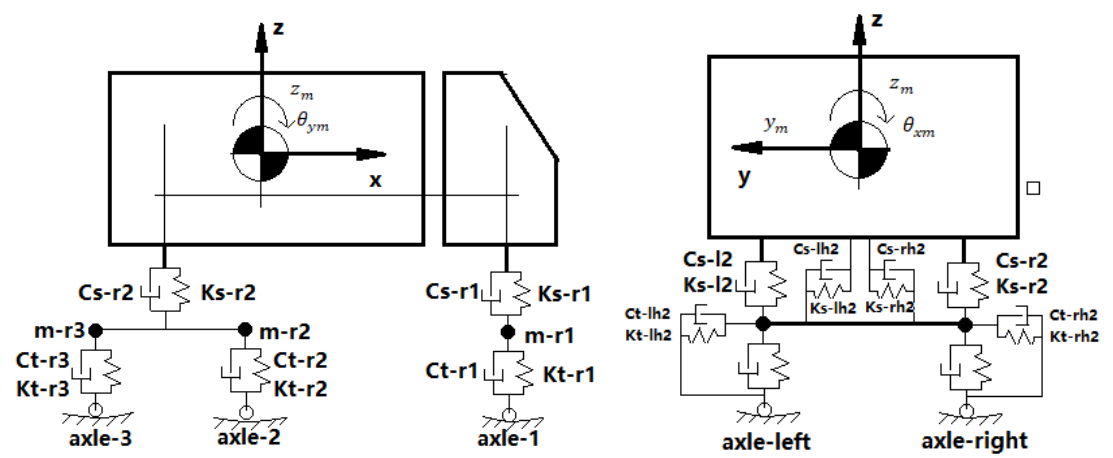
Fig. 1. 3D truck model side view (left) and rear view